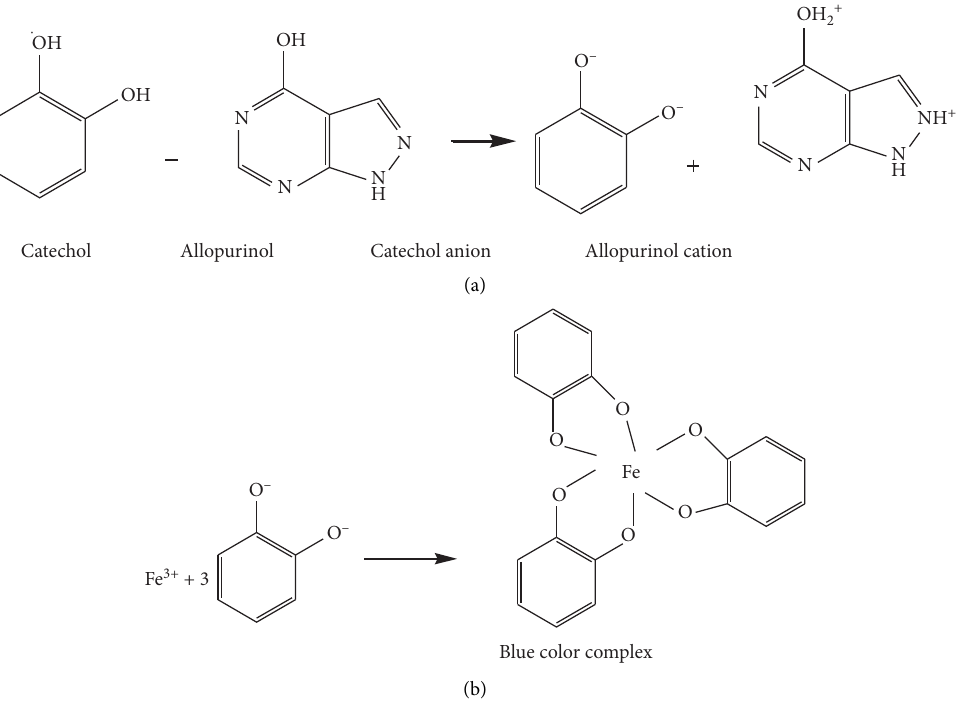
Figure 2: (a) Ionization of catechol along with ALLP and (b) blue color complex formation.